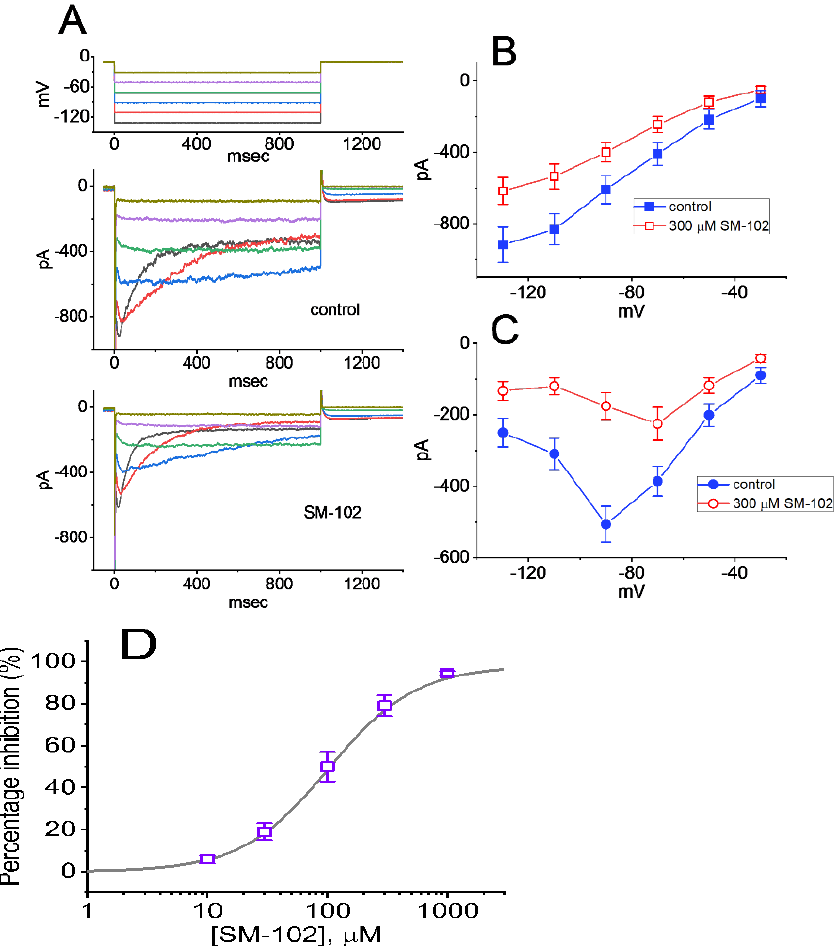
Figure 6. Effect of SM-102 on I K(erg) recording from MA-10 Leydig cells. In these experiments, MA-10 cells were dispersed and then bathed in high-K + , Ca 2+ -free solution, and the recording electrode used was filled up with K + -enriched solution. ( A ) Representative I K(erg) traces obtained in the absence (upper) and presence (lower) of 300 µ M SM-102. In ( B ) or ( C ), the I–V relationship of peak or late (or sustained) I K(erg) was demonstrated, respectively. Current amplitude was measured at the start ( B ) or end ( C ) of each hyperpolarizing pulse. Closed (square or circle) symbols in ( B , C ) are controls (i.e., SM-102 was not present), while open (square or circle) symbols were taken during cell exposure to 300 µ M SM-102. Each point represents the mean ± SEM ( n = 8). ( D ) Concentration-dependent inhibition of SM-102 on the amplitude of I K(erg) taken from MA-10 cells. Current amplitude was measured at the start of hyperpolarizing pulse from − 10 to − 90 mV (mean ± SEM; n = 8 for each point).